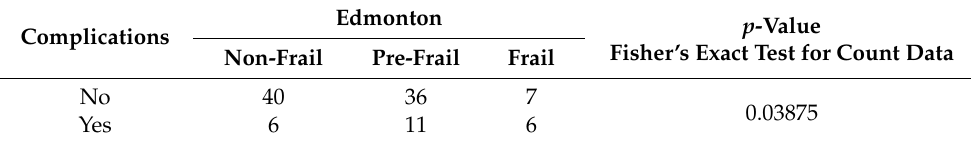
Table 3. Edmonton variables contingency table—complications during hospitalization.